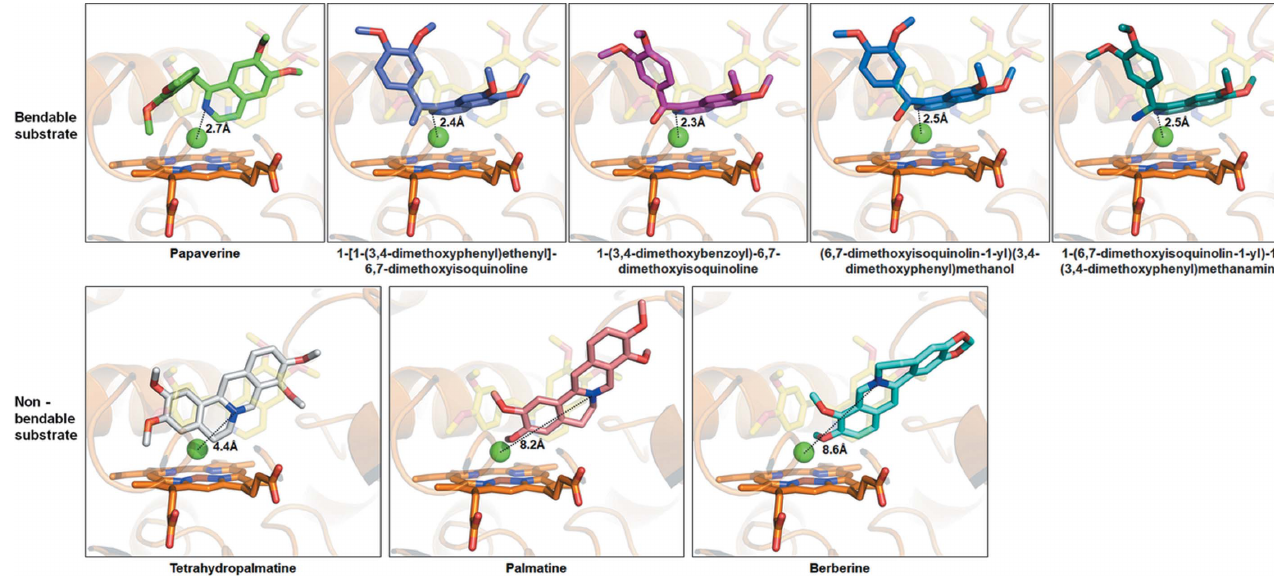
Figure 9 Comparison of bendable and non-bendable substrates. Co-crystallized papaverine and heme molecules with CYP105D18 are shown as yellow and orange sticks. Each potential substrate after the docking calculation was represented with sticks with different color codes. The distances between the water molecules interacting with heme in CYP105D18 and nitrogen are indicated in each figure. Docking experiments were performed using the Lamarckian genetic algorithm (LGA) method in Autodock Vina (Trott & Olson,